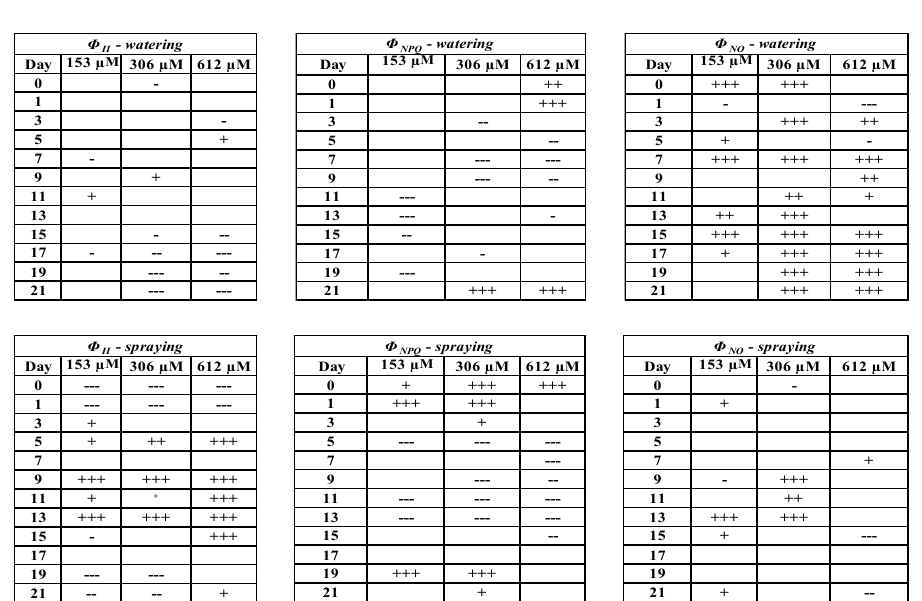
Figure 8. Mean values, expressed in arbitrary units (AU), of Φ II , Φ NPQ and Φ NO from A. thaliana adult plants watered or sprayed for 21 days with different concentrations of norharmane (0, 153, 306 and 612 µM). Tables show the statistical significance compared to the control on each day and treatment (+, stimulatory difference; -, inhibitory difference; + or -, p ≤ 0.05, ++ or --, p ≤ 0.01, +++ or --- p ≤ 0.001).